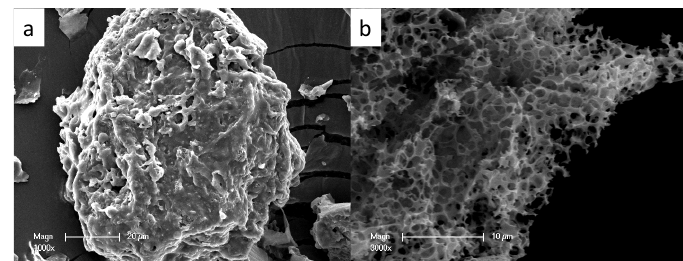
Figure 1. SEM images of ( a ) BS-800 and ( b ) BSNC-800-4.